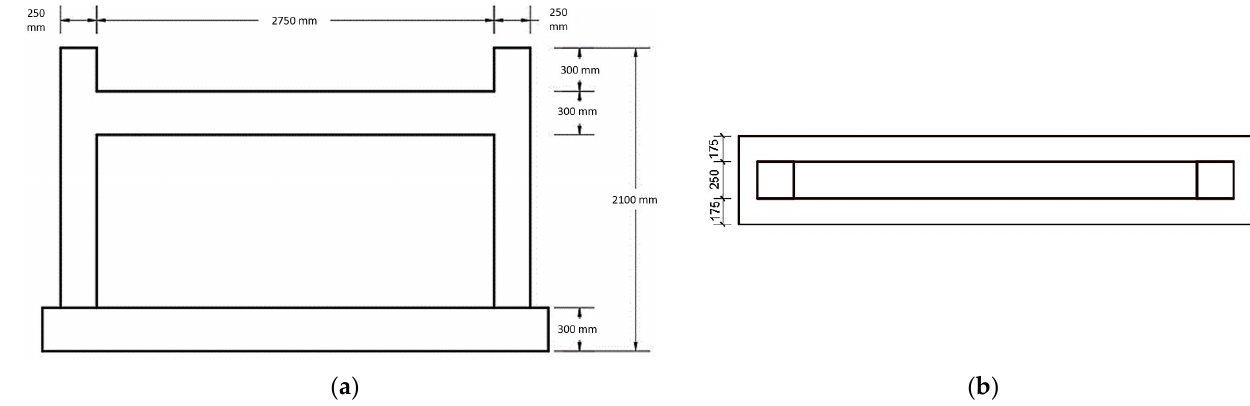
Figure 1. General layout of tested frames: ( a ) Side view; ( b ) top view